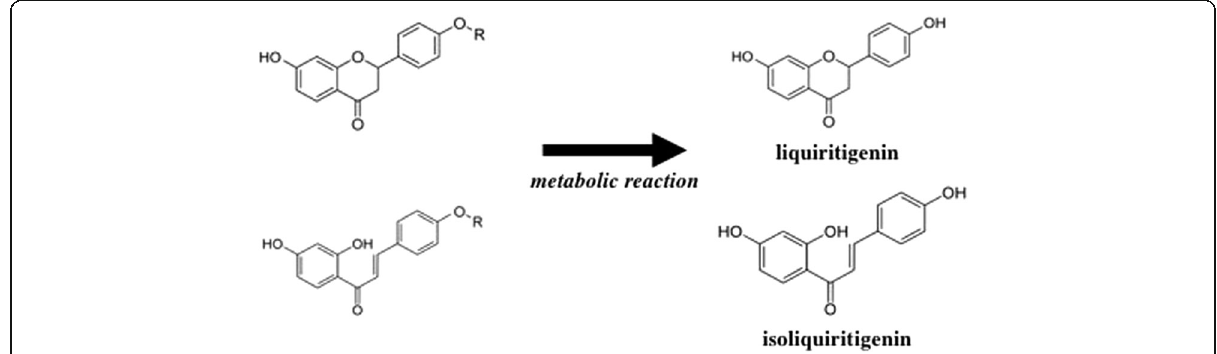
Fig. 6 A proposed metabolic pathway. R: a sugar group or a methyl